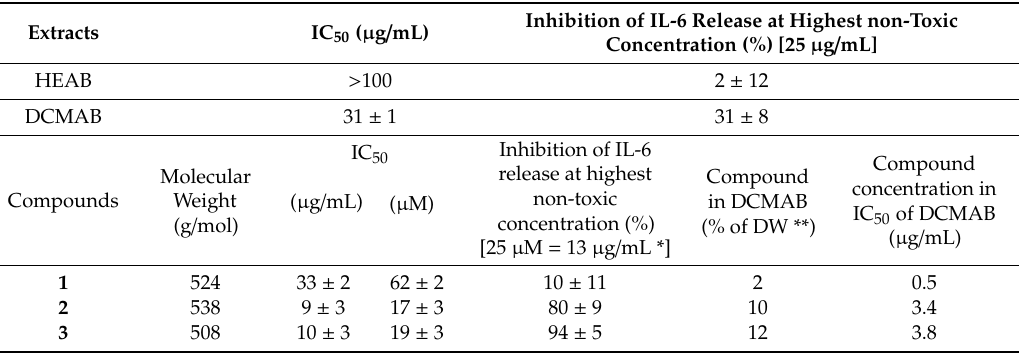
Table 1. IL-6 inhibitory activity and anti-inflammatory IC 50 of all tested